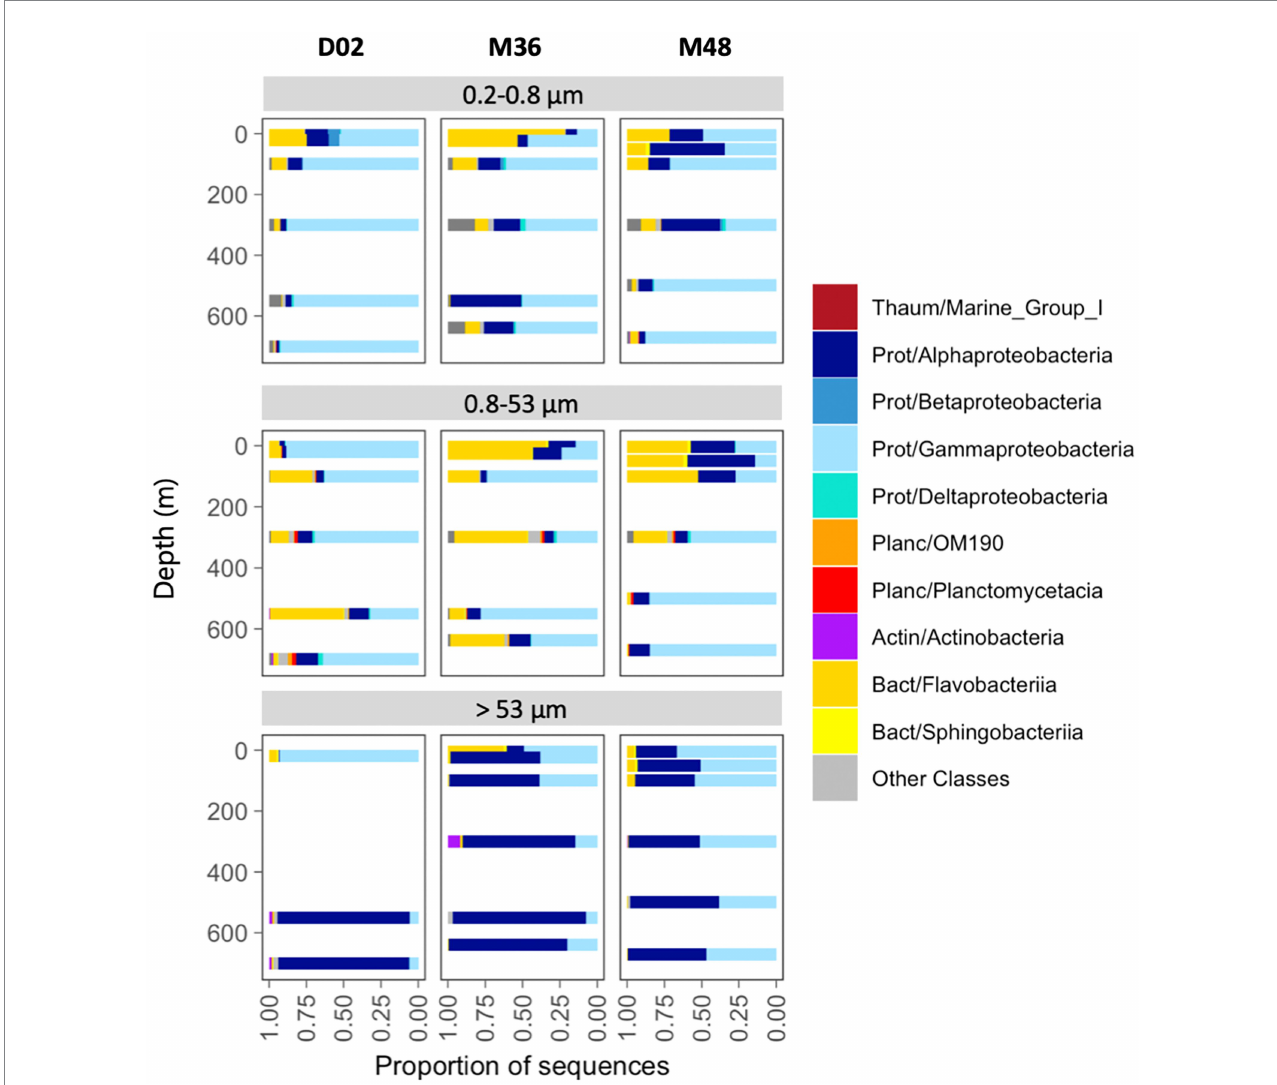
FIGURE 3 Taxonomic composition across size-fractions and depth in the three stations. The classification was performed at the class level, indicating the phylum: Thaum, thaumarchaeota; Actin, actinobacteria; Bact, bacteroidetes; Planc, planctomycetes; Prot,